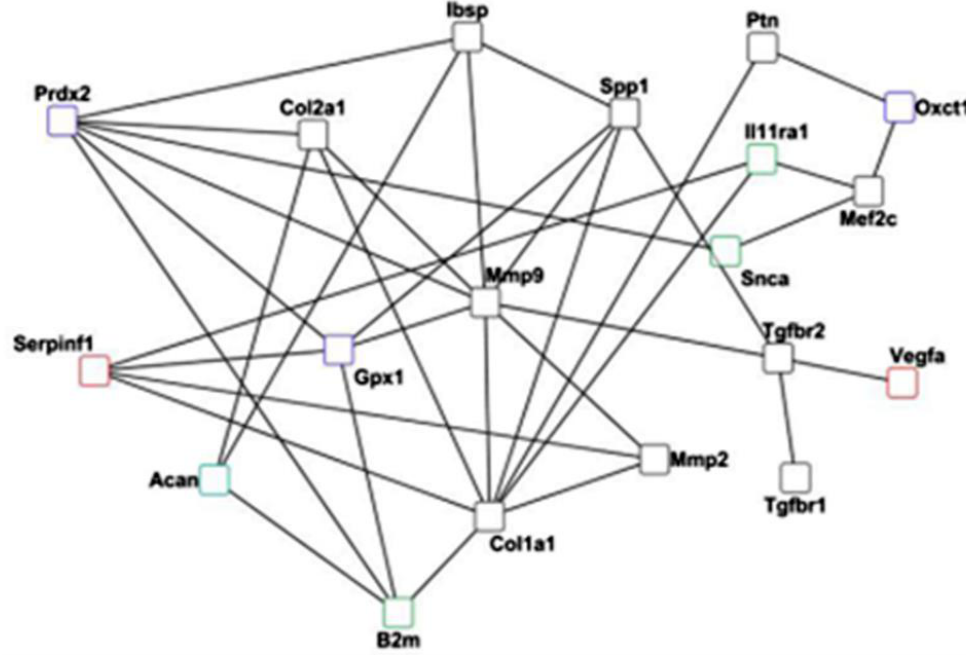
Figure 9. Network analysis carried out using GeneMania depicts the cross-talk between differentially expressed genes.